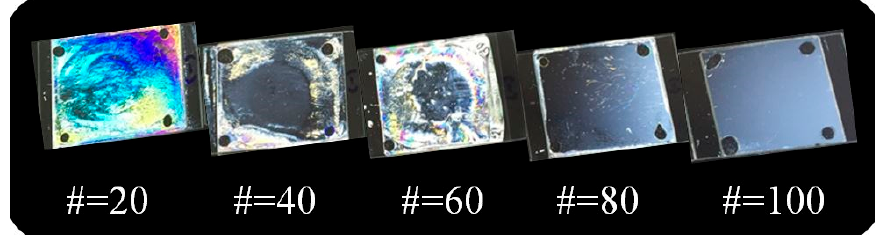
Figure 4. Photograph images of the LC cells made from PEUG# films according to the molar content of eugenol moiety.